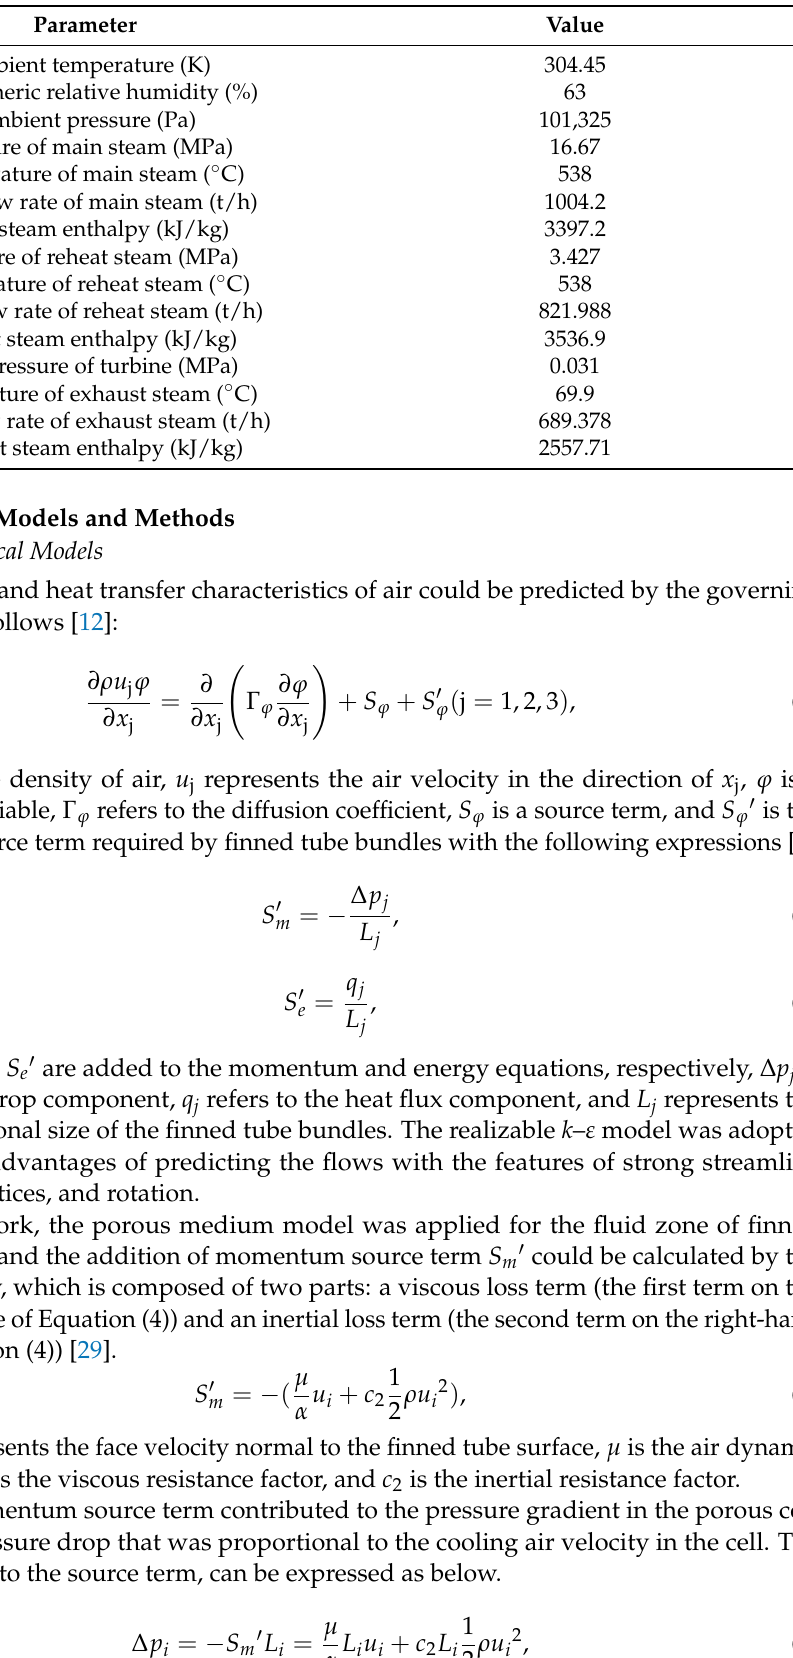
Table 2. Main parameters of TRL operating